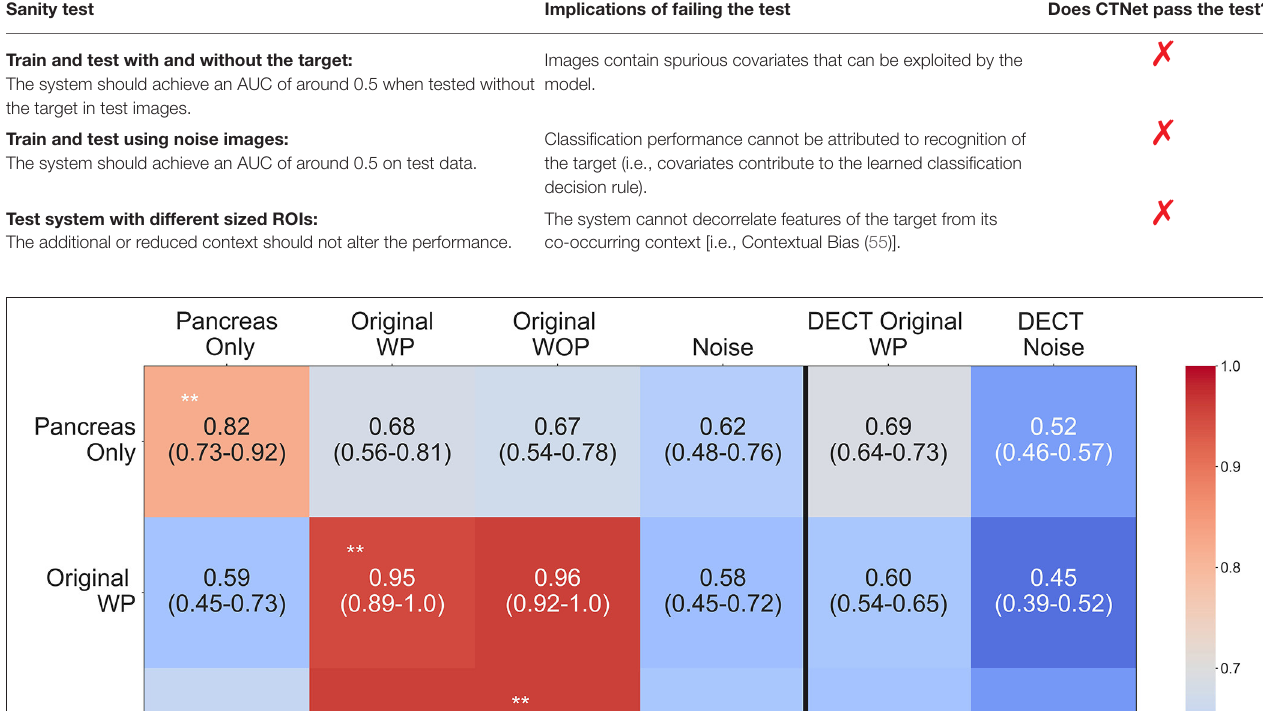
Images contain spurious covariates that can be exploited by the model.